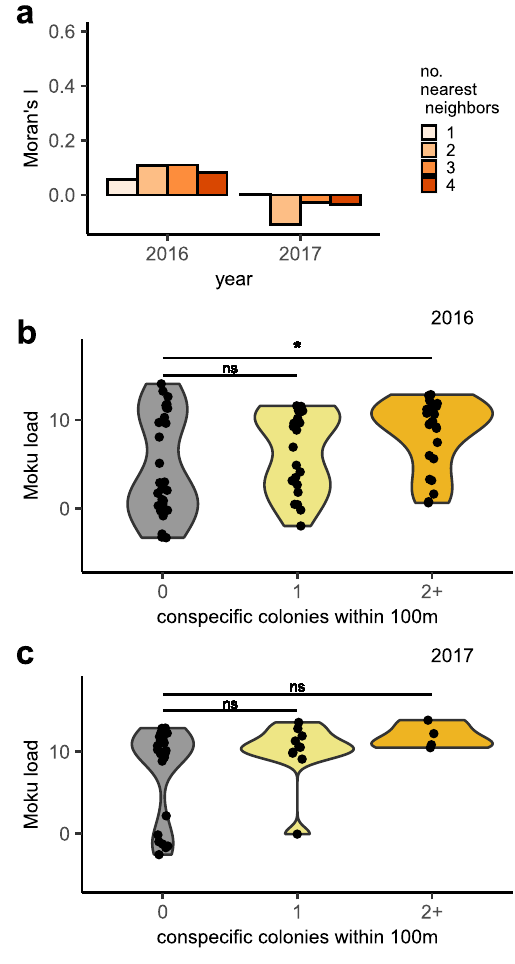
Figure 4. Spatial patterns in colony-level Moku virus load. (a) Moku load is not spatially autocorrelated, as Moran’s I was close to, and not significantly different from, zero, for nearest neighbors defined as the closest 1–4 colonies (p > 0.05 for all Moran’s I tests). (b) In 2016, colonies > 100 m from other conspecific colonies were significantly more likely to have low Moku loads than colonies with two or more close neighbors (binomial GLM; n = 74, z = 2.3, p = 0.02; “High” vs “Low” threshold relative load was 2; see Fig. 1, Supplementary Figure S1 and main text). (c) The same trend was observed in 2017, but the difference was not statistically significant. Violin plots, created using ggplot2, depict the density of points in each category. * indicates p < 0.05. “ns” indicates not